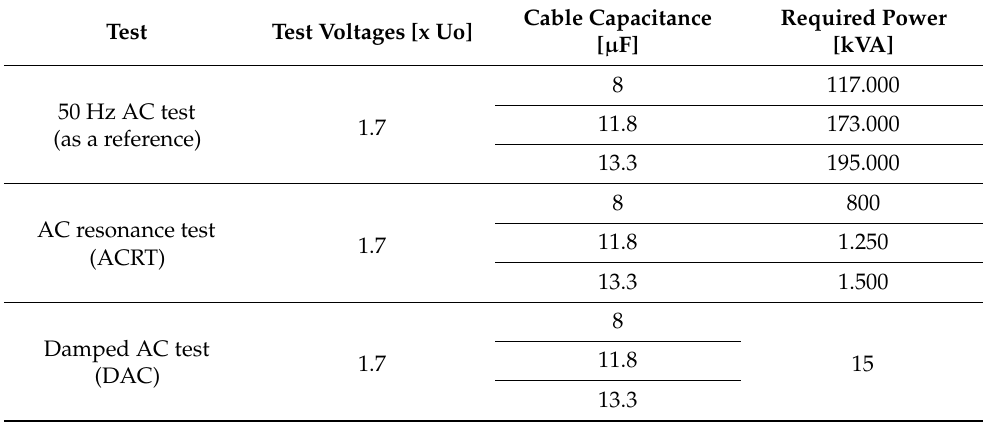
Table 2. Estimation of input power needed for testing a typical 50 km long 220 kV cable (per single phase). Test Test Voltages [x